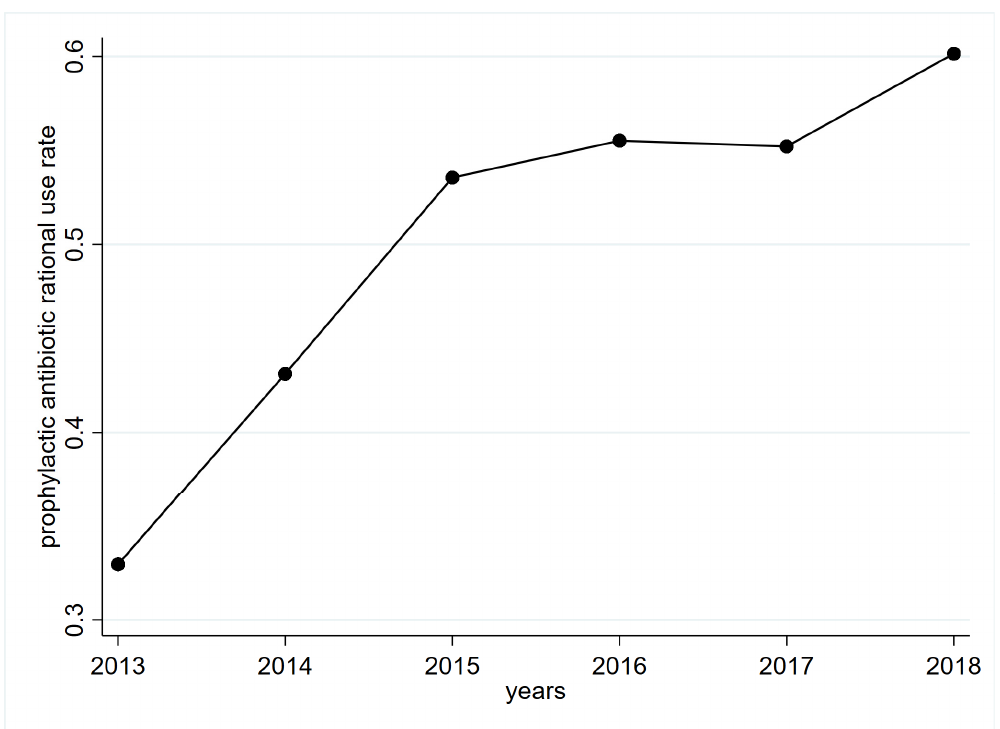
Figure 1. Trends of perioperative prophylactic antibiotic rational use rate in FAH, SYSU general surgery department. FAH, SYSU: First Affiliated Hospital of Sun Yat-sen University.